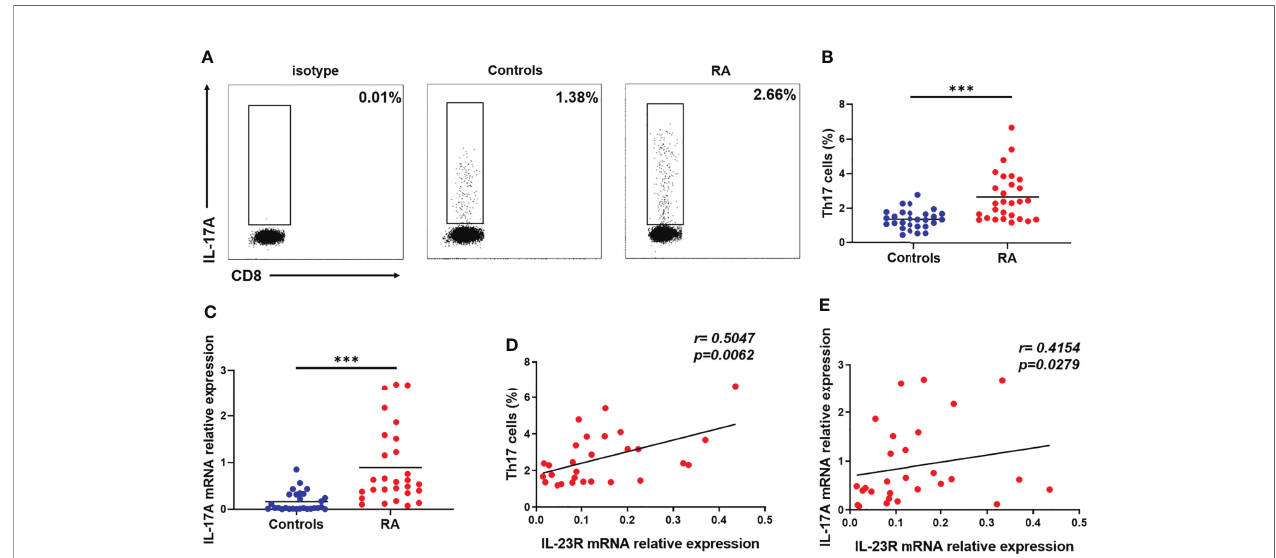
FIGURE 4 | Correlation between IL-23R expression and circulating Th17 cells in RA patients. Fresh peripheral blood was collected, PBMCs were subsequently isolated from peripheral blood within four hours, and the proportion of Th17 cells was analysed by fl ow cytometry. (A) Representative fl ow cytometry dot plots of Th17 cells in RA patients and controls. Values in the upper left rectangular region corresponded to the proportion of Th17 cells. CD3 + CD8 - IL-17A + cells were gated as Th17 cells. (B) The difference in the proportion of Th17 cells between 28 RA patients and 28 controls is shown. (C) The relative expression of IL-17A mRNA in PBMCs from 28 RA patients and 28 controls was determined by qRT – PCR. The correlation between IL-23R expression and the percentage of Th17 cells (D) and IL-17A levels (E) in 28 RA patients. Each data point represents an individual subject, horizontal lines show the mean. *** p <